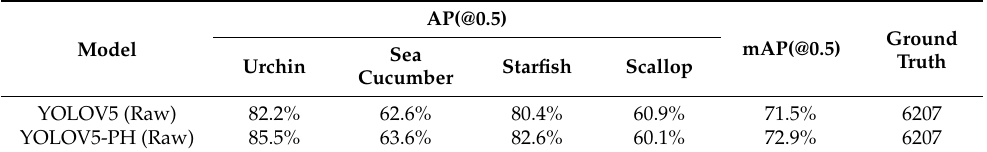
Table 3. Performance comparison of prediction head optimization.